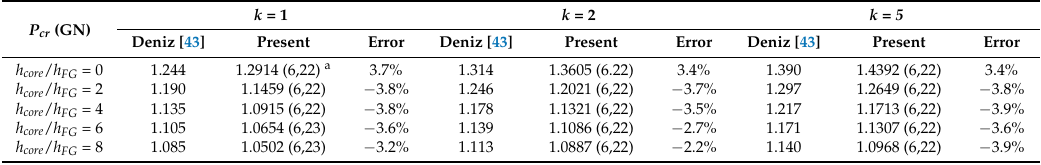
Table 4. Comparisons of nondimensional critical axial loads (calculated by Equation (27)) for un-stiffened three-layered FG/Metal/FG truncated conical shells with various ratio h core / h FG . k = 1 k = 2 k = 5 P cr (GN) Deniz [43] Present Error Deniz [43] Present Error Deniz [43] Present h core / h FG =